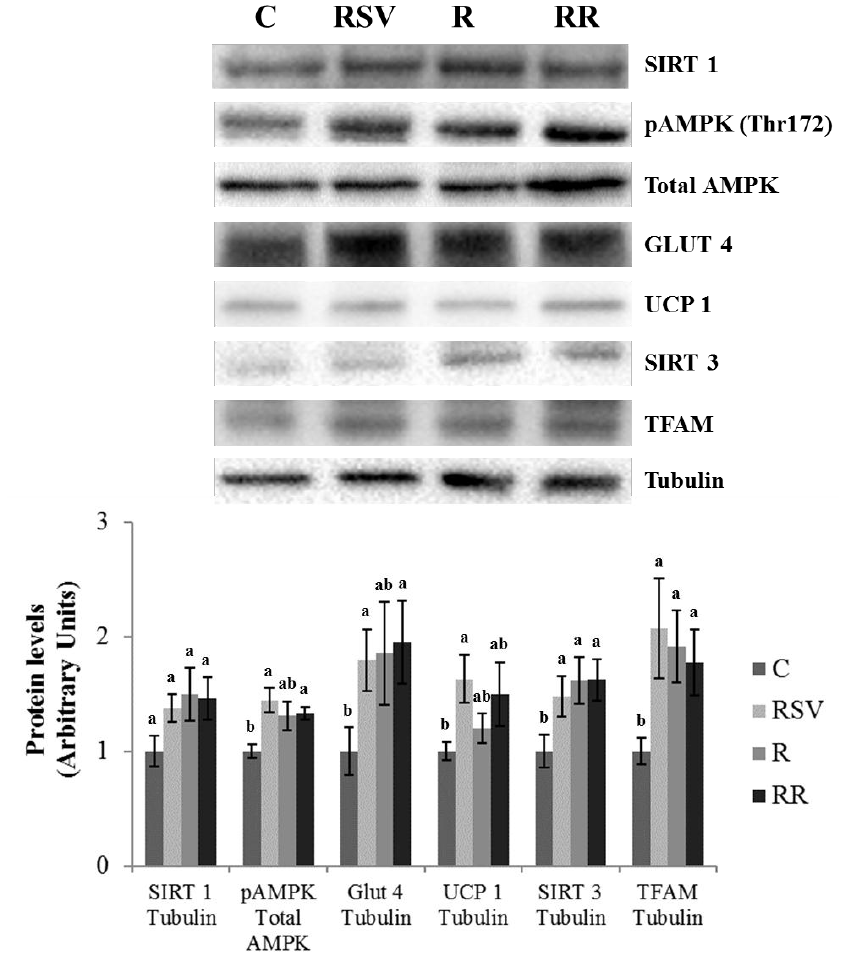
Figure 4. Protein levels of SIRT1, GLUT4, UCP1, SIRT3 and TFAM, and threonine 172 phosphorylation ratio of AMPK in IBAT of rats fed an obesogenic diet for 6 weeks and then shifted to a standard diet (C), or standard diet supplemented with resveratrol (RSV), or submitted to energy restriction and fed a standard diet (R), or submitted to energy restriction and fed a standard diet supplemented with resveratrol (RR) ( n = 9/group) for additional 6 weeks. Values are represented as means ± SEM. Differences among groups were determined by using one-way ANOVA followed by Newman–Keuls post hoc test. Values not sharing a common letter are significantly different ( p < 0.05). SIRT1: sirtuin 1, GLUT4: glucose transporter 4, UCP1: uncoupling protein 1, SIRT3: sirtuin 3, TFAM: mitochondrial transcription factor A, AMPK: AMP activated protein kinase, IBAT: interscapular brown adipose tissue.